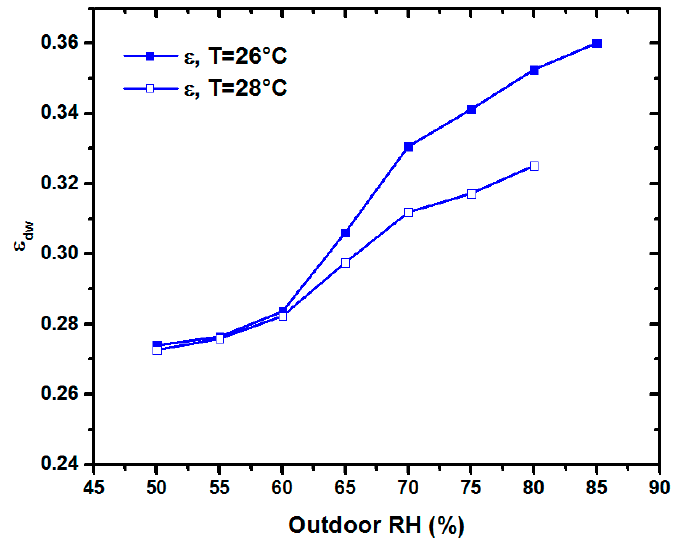
ff ect of outdoor RH on desiccant e ff Figure 8. Effect of outdoor RH on desiccant effectiveness. Figure 8. E